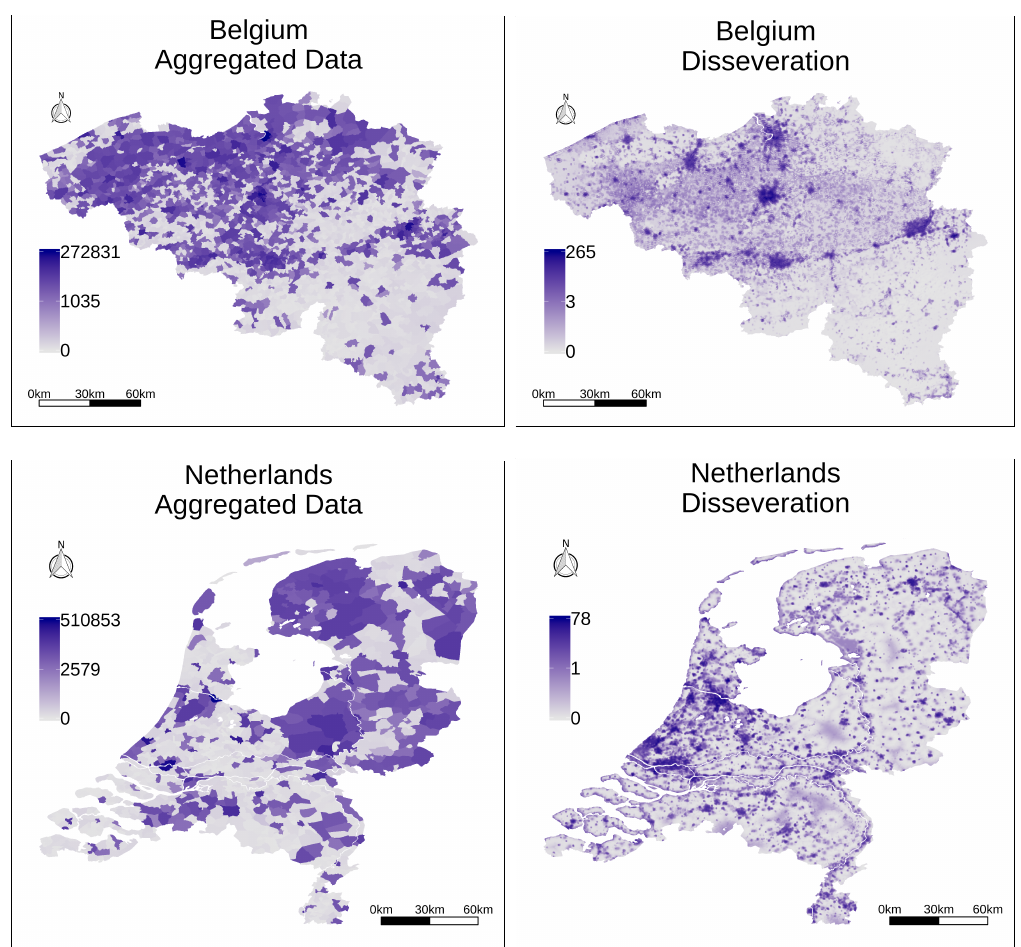
Figure 5. Results for the disaggregation of historical population